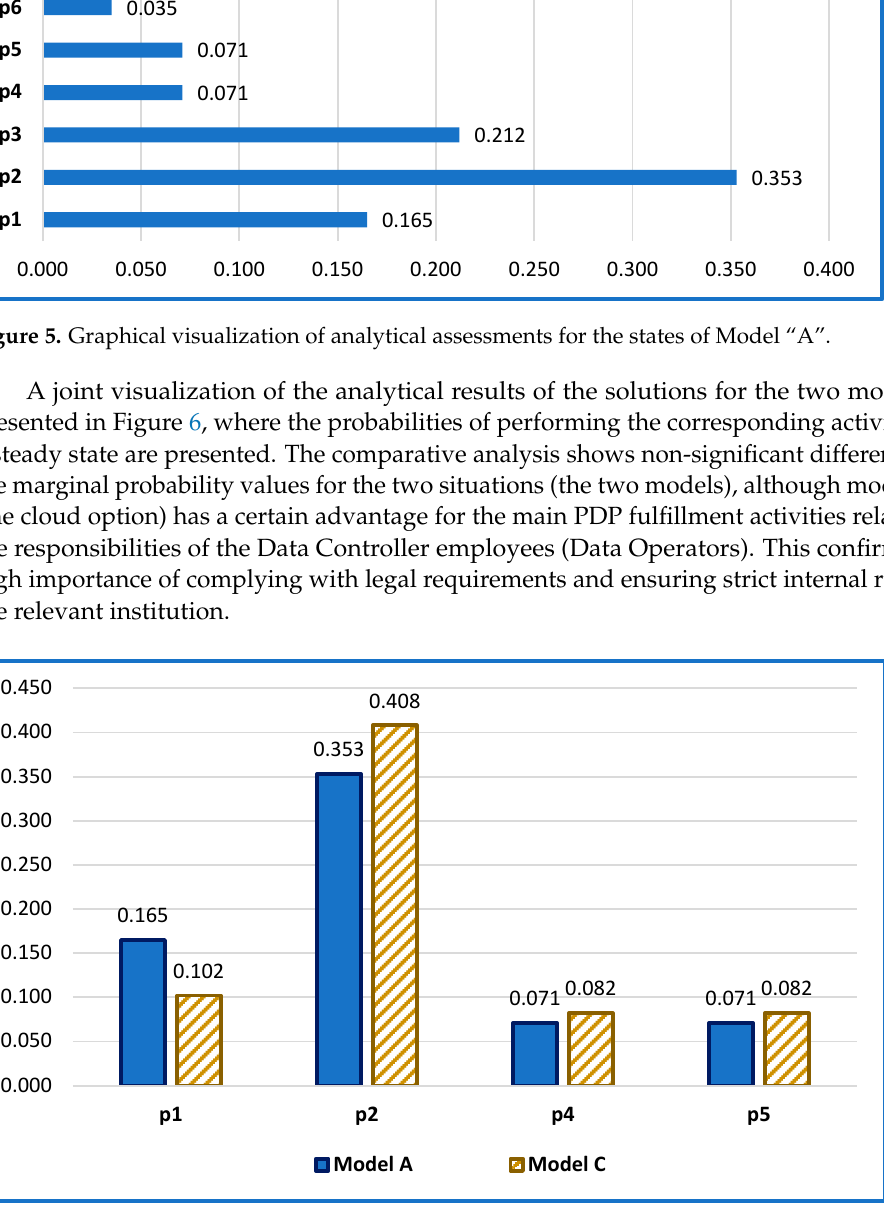
Figure 6. Comparison of basic activities for the two models.